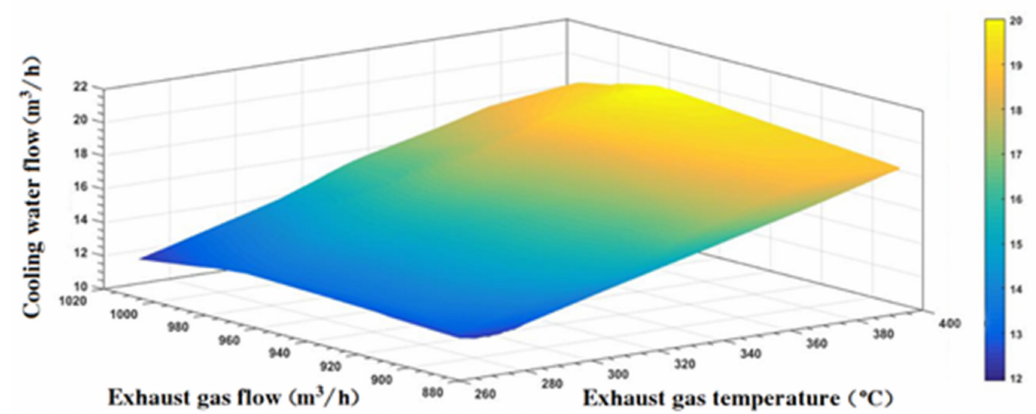
Figure 13. The relationship between the predicted cooling water flow and exhaust gas.